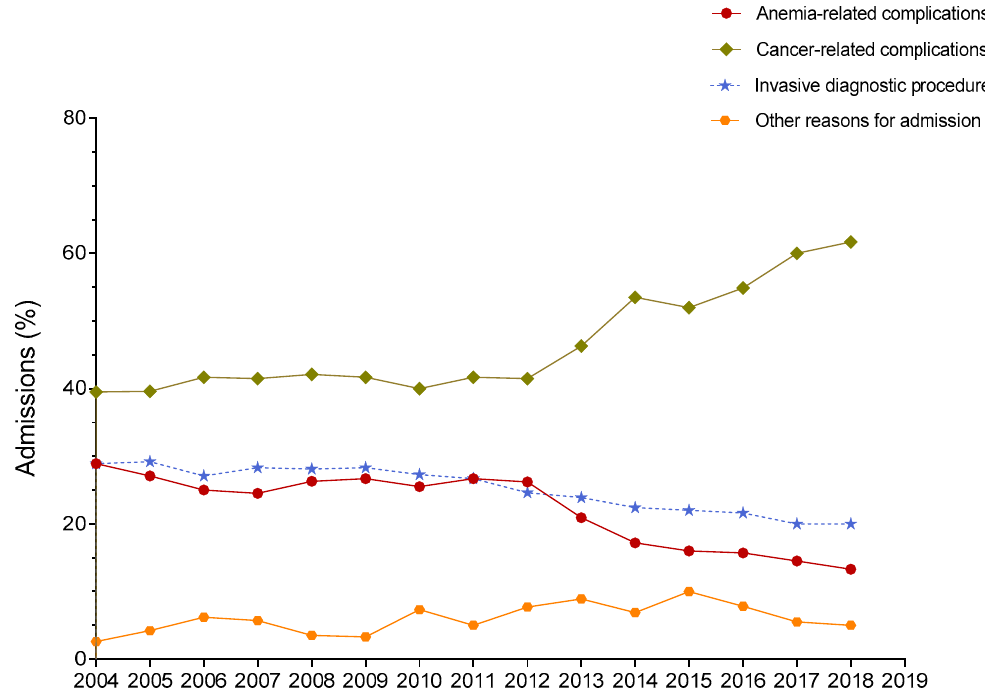
Figure 3. Trends in admissions according to the main categories of reasons for admission.